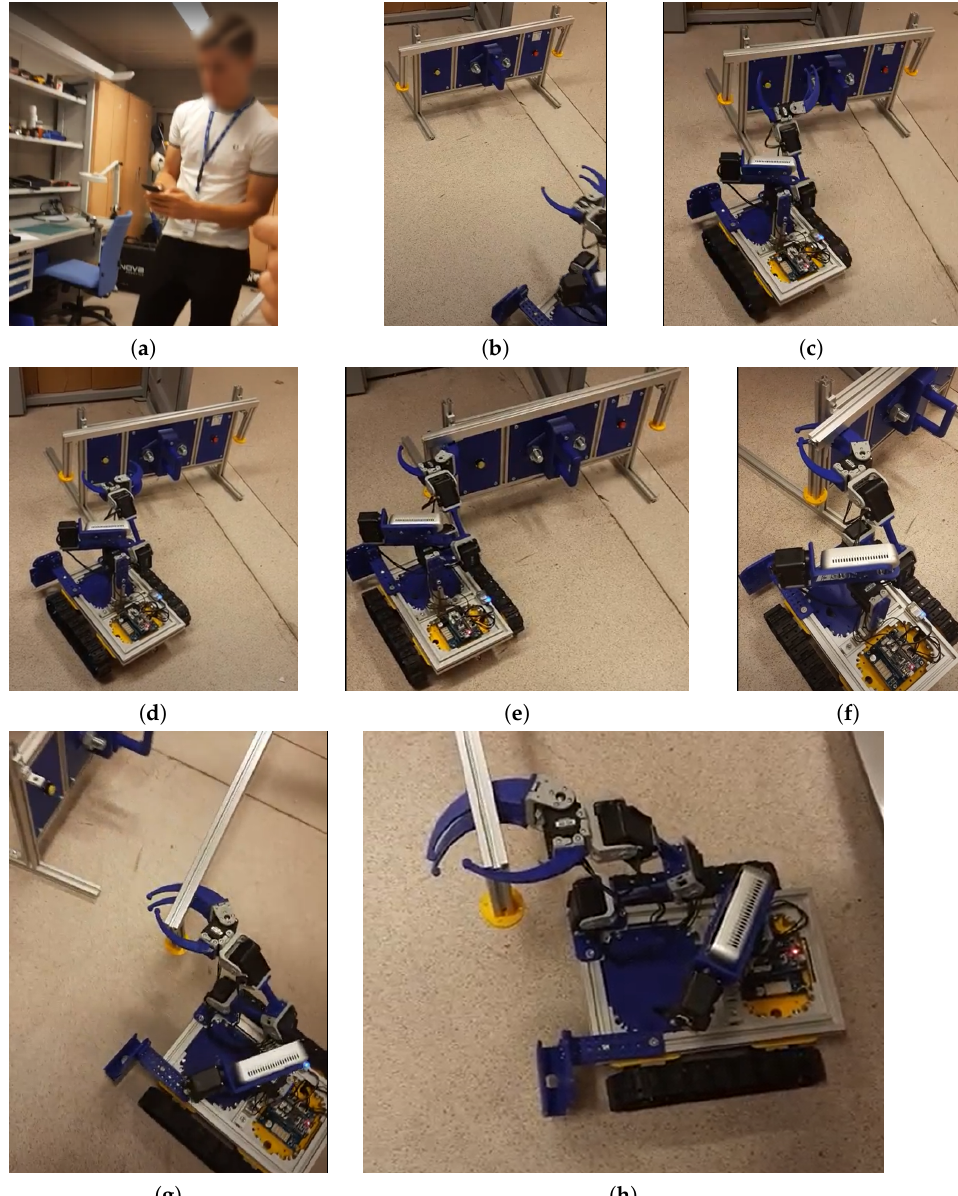
Figure 21. Comparison of steady state results ( a ) student teleoperating the robot to accomplish the first mission; ( b ) robot approaching panel; ( c ) student preparing arm to get the bar; ( d ) student preparing the approach to the bar; ( e ) closing the griper; ( f ) bar taken; ( g ) taking the bar back to the base; ( h ) bar recovered, mission